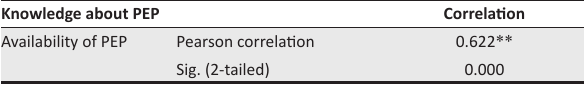
TABLE 3: Correlation coefficients of knowledge about PEP and availability of PEP. Knowledge about